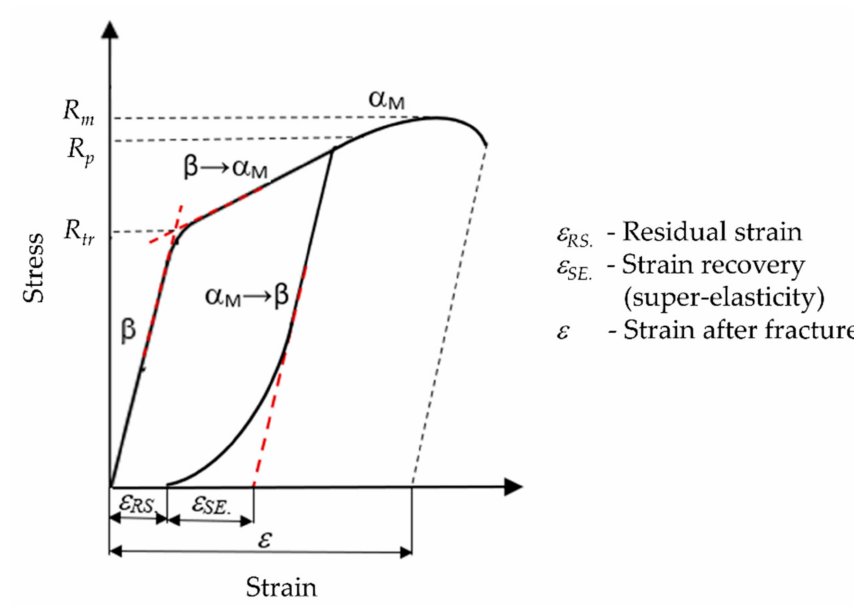
Figure 5. Stress–strain curve of polycrystalline Cu-Zn-Al shape memory alloy